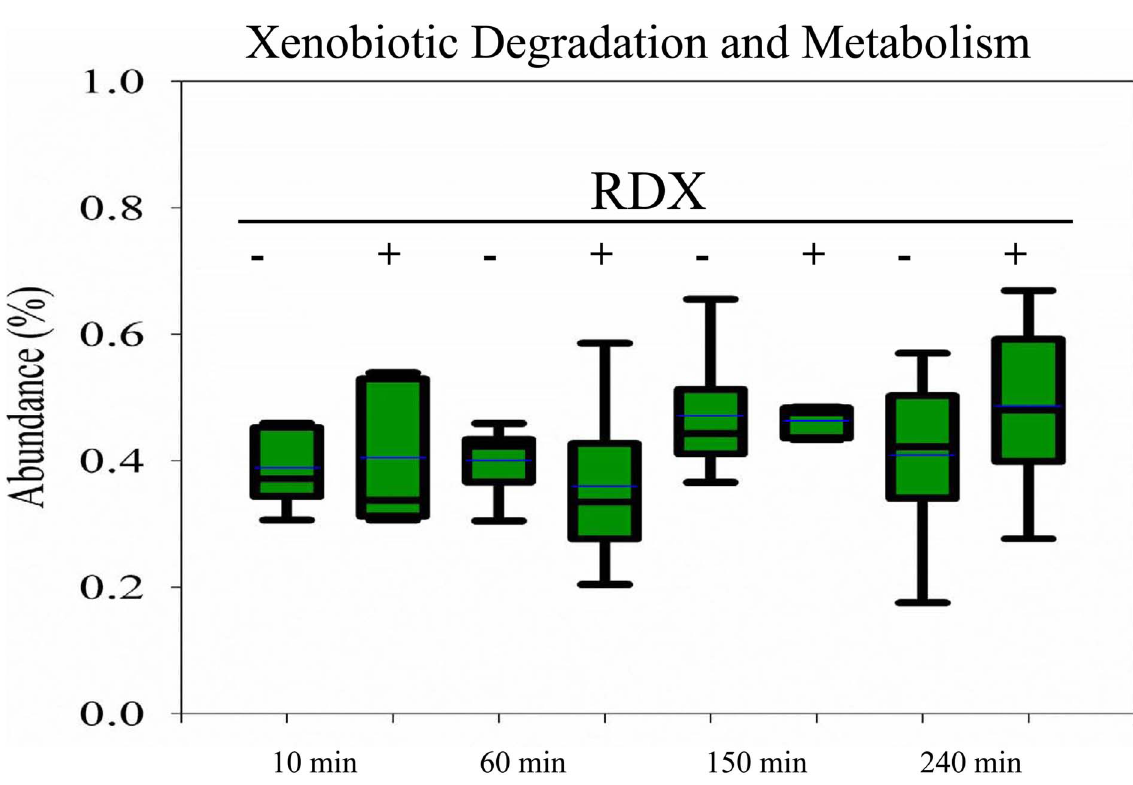
Figure 4. Relative abundance of sequences annotated to the KEGG Xenobiotic Biodegradation and Metabolism term during exposure of the ovine rumen to RDX over four hours. Boxes denote the inter-quartile range between the first and third quartiles (25 and 75%, respectively). (–): time-matched WRF control without RDX exposure. ( + ): WRF incubated with 40 m g/ m l RDX.